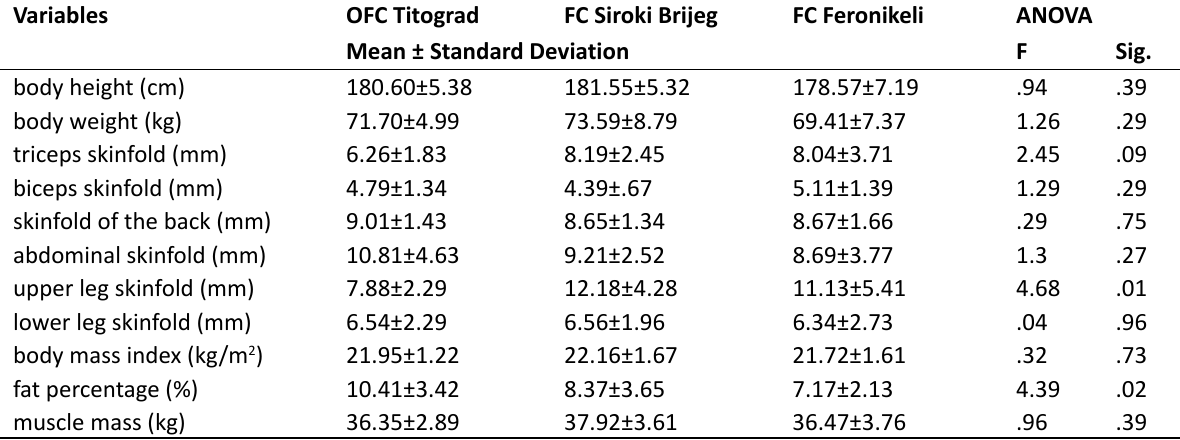
Table 1. Descriptive data and ANOVA of 46 young soccer players, members of the three clubs